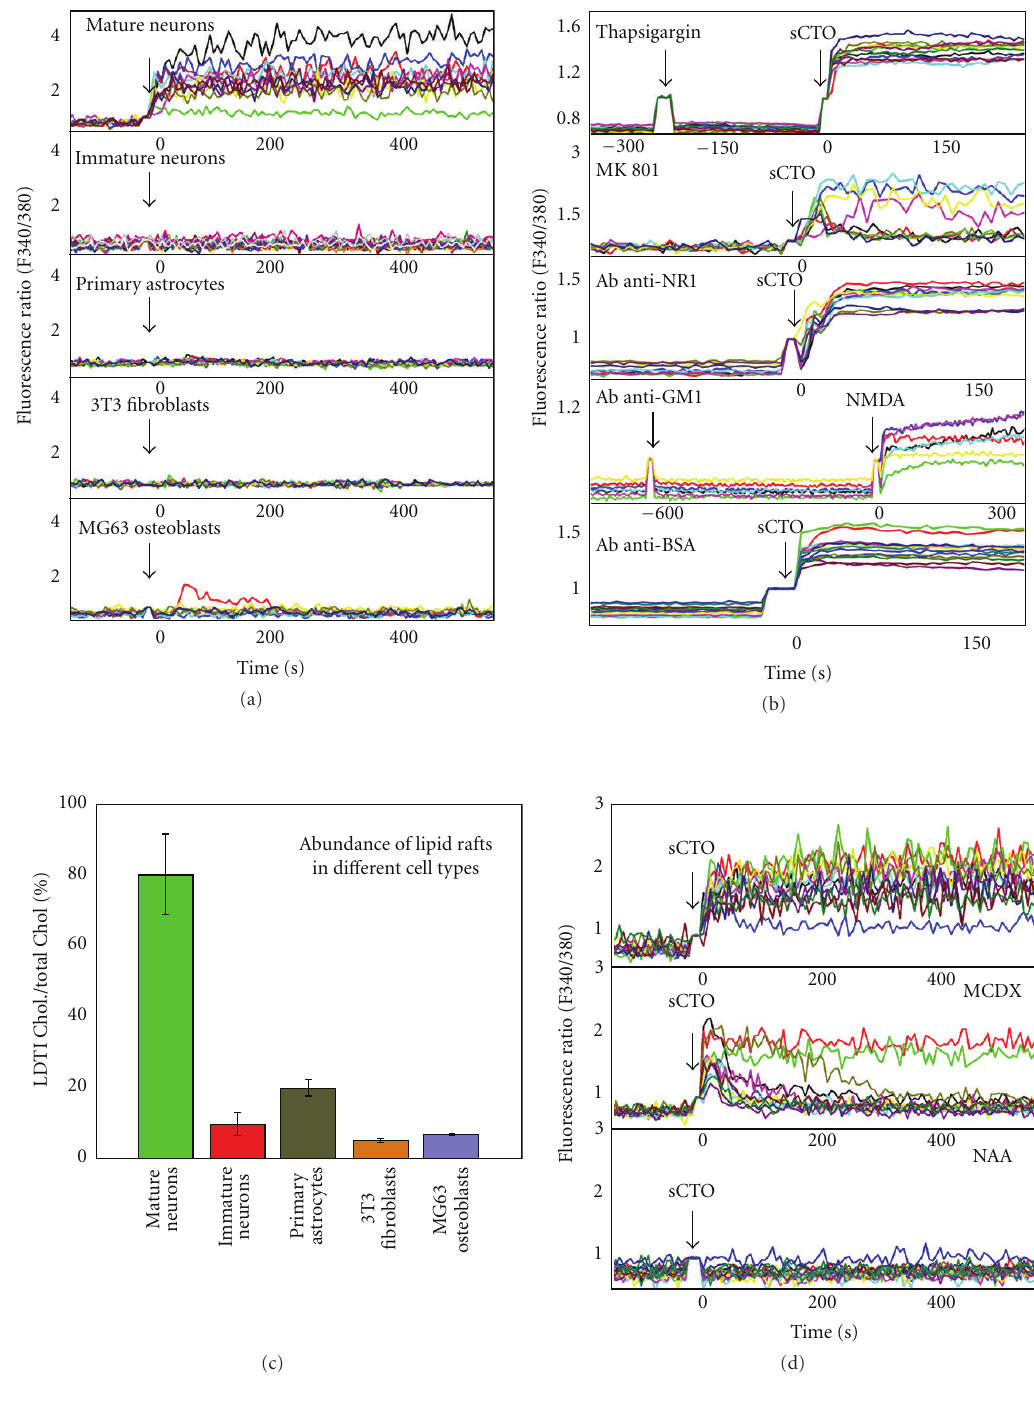
Figure 6: (a) sCTO induces increase in intracellular Ca 2+ levels in mature hippocampal neurons, but not in immature neurons, primary astrocytes, 3T3 fibroblasts, and MG3 osteoblasts. Ca 2+ levels were evaluated by optical fluorimetric recordings with Fura-2AM. (b) Depletion of intracellular Ca 2+ stores with thapsigargin did not a ff ect sCTO-induced Ca 2+ rise, suggesting that it was mostly due to an extracellular Ca 2+ influx. MK801, a specific NMDA inhibitor, as well as antibodies against NR1, failed to a ff ect sCTO-driven Ca 2+ influx, suggesting that the NMDA receptor was not involved. On the contrary, pretreatment with an antibody against the ganglioside GM1, aimed at blocking LRs, completely abolished sCTOs-induced Ca 2+ increase. Pretreatment with anti-BSA IgGs, an unrelated antibody, did not a ff ect sCTO response. (c) Measure of the weight ratio between cholesterol in LRs (LDTI) and total cholesterol indicates that plasma membrane of mature hippocampal neurons have a much higher content in LRs than the other cell types. (d) Pretreatment of hippocampal neurons with NAA totally suppressed sCTO-induced Ca 2+ increase. Reproduced with permission and partially modified from